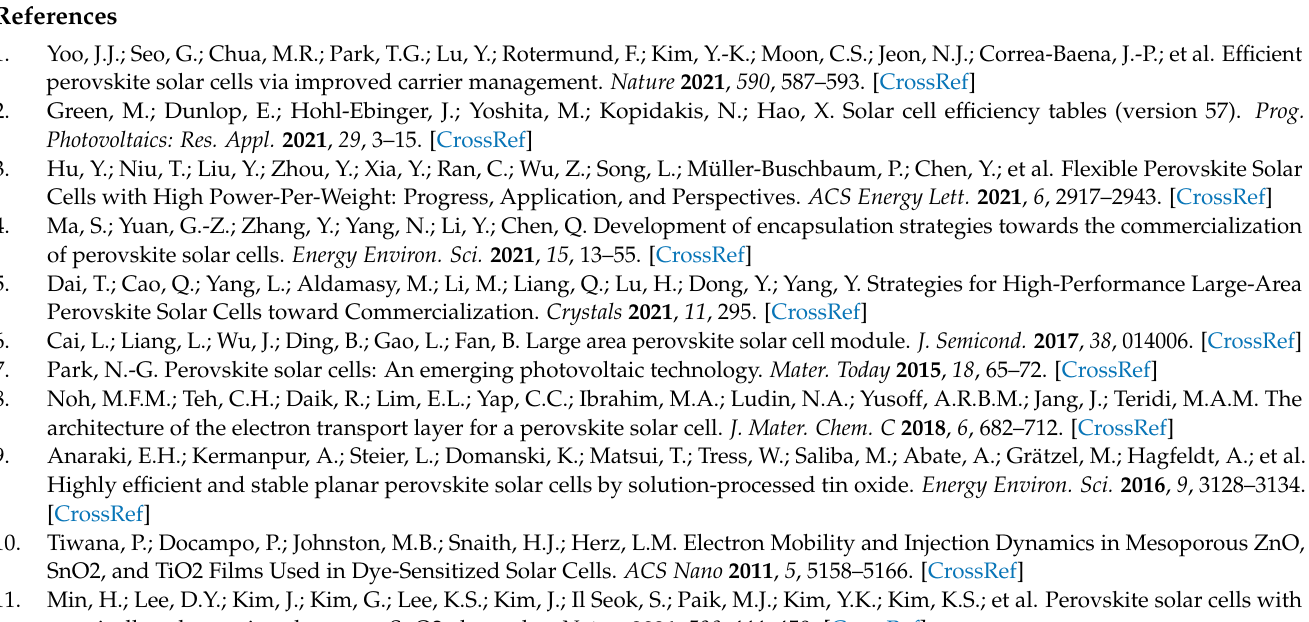
Figure S4: Reverse scan (solid line) and forward scan (dotted line) current density–voltage curves of PSCs based on SL-PSC, BLL-PSC, and BLP-PSC; Table S1: Summary of the photovoltaic parameters of PSCs based on SnO 2 ETL annealed at 200, 300, and 400 ◦ C; Table S2: Summary of EIS data; Table S3: Summary of the photovoltaic parameters of SL-PSC, BLL-PSC, and BLP-PSC according to scan